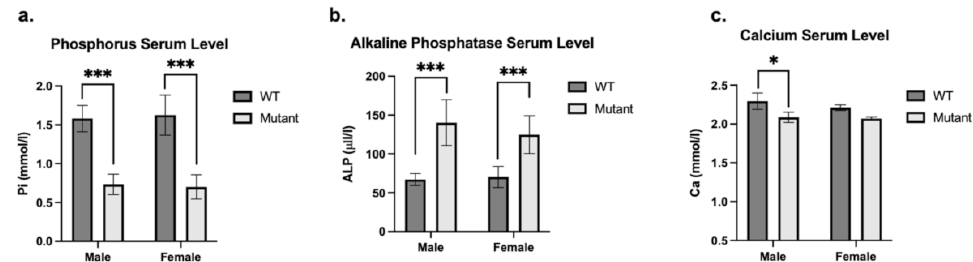
Figure 3. Plasma biochemical analysis of mutant and WT mice. Phosphorus (Pi mmol/l) ( a ), Alkaline Phosphatase (ALP U/l) ( b ) and Calcium (Ca mmol/l) ( c ) plasma level of sex-matched mutant (light grey bars) and WT (dark grey bars) mice. Mutant males are hemizygous ( Phex L222P /Y) and mutant females are heterozygous ( Phex L222P / Phex ). Error bars indicate standard deviation. One-way ANOVA test was used to compute p -values, significance was indicated with asterisks (* p -value < 0.05; *** p -value <